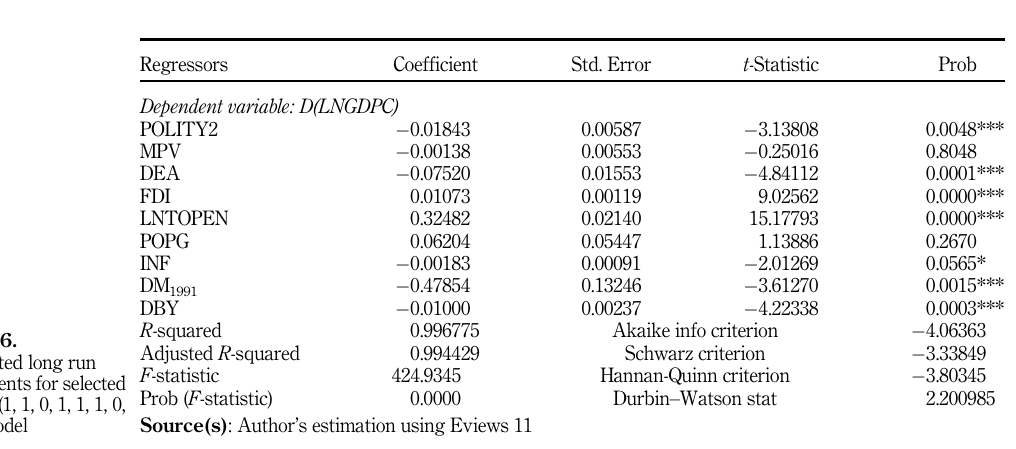
Figure 2. Cumulative sum